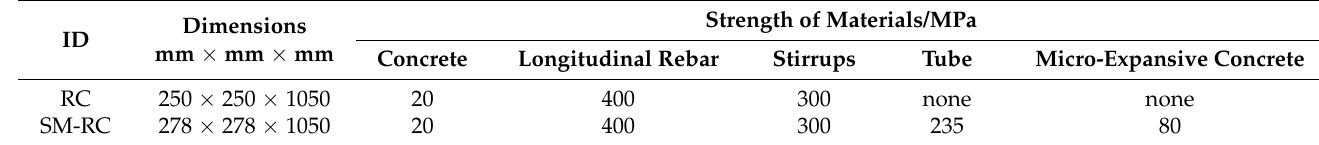
Table 1. Detailed parameters of test